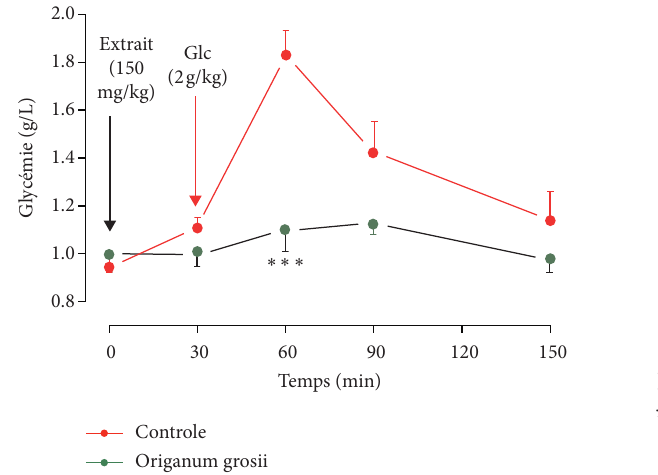
Figure 5: Antihyperglycemic effect of O. grosii extract in normal